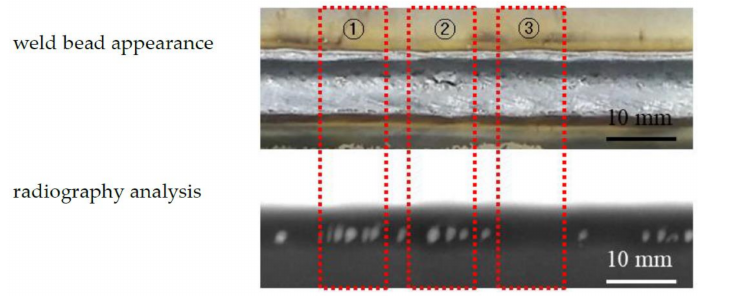
Figure 2. Schematic diagram of the fatigue specimen (unit: mm).